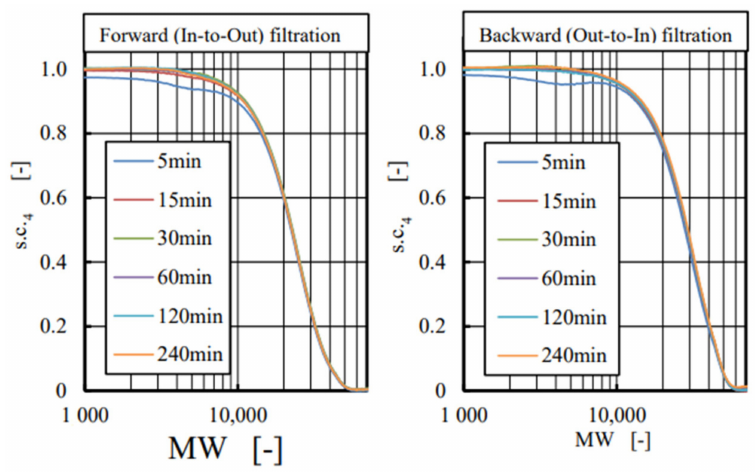
Figure 7. Relationship between the sieving coefficient (s.c. 4 ) and MW in intact ATA ® membrane module (FIX) using dextran with wide variety of MW. No changes were found with